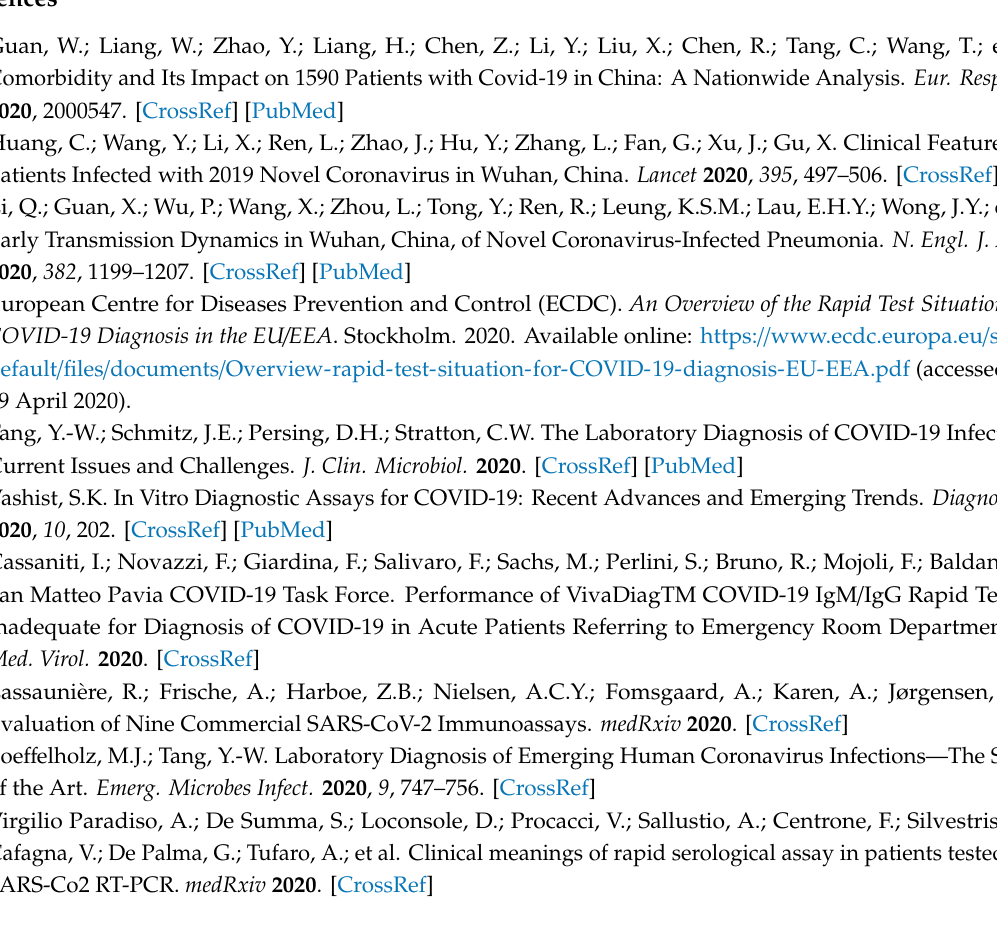
Figure A3. sROC curve for POC data. The slight differences between estimates from a random-effects model and a fixed-effects model suggest the absence of a threshold effect in diagnostic performances of assessed tests.